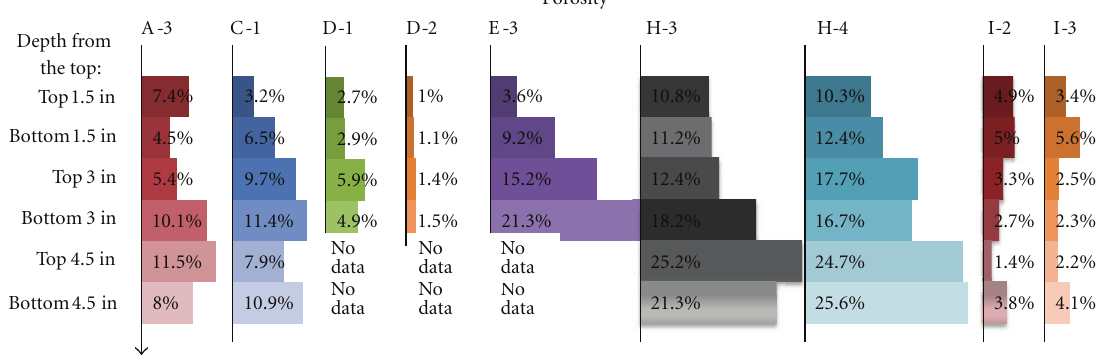
Figure 6: Porosity of nine concrete samples with respect to core depth evaluated using image analysis of sliced cores.